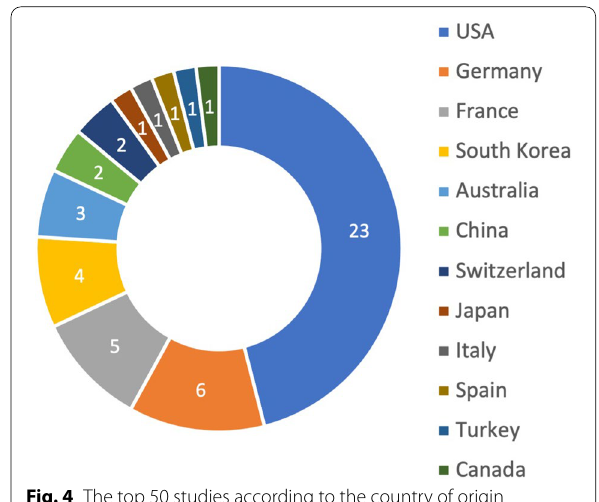
Fig. 4 The top 50 studies according to the country of